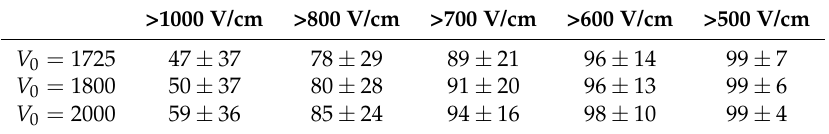
Table 9. Ablation zones percentage. Table shows percentage of tumor above a given electrical field strength from varying σ 0 for both the liver tissue and the tumor.